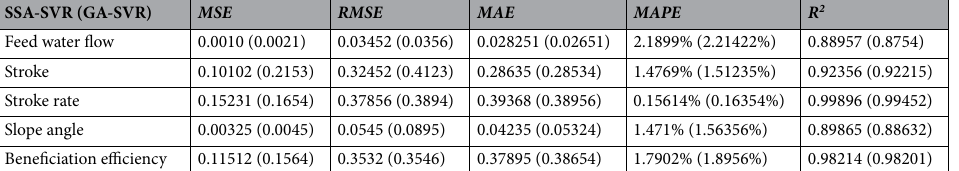
Table 3. Simulation result of the models (To supplement the sample data and re-do the training for further